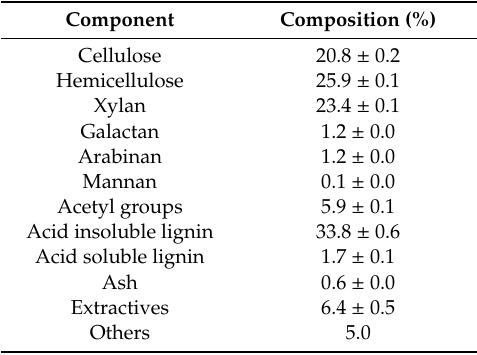
Table 1. Composition in % of dry weight basis (dwb) of raw OS biomass